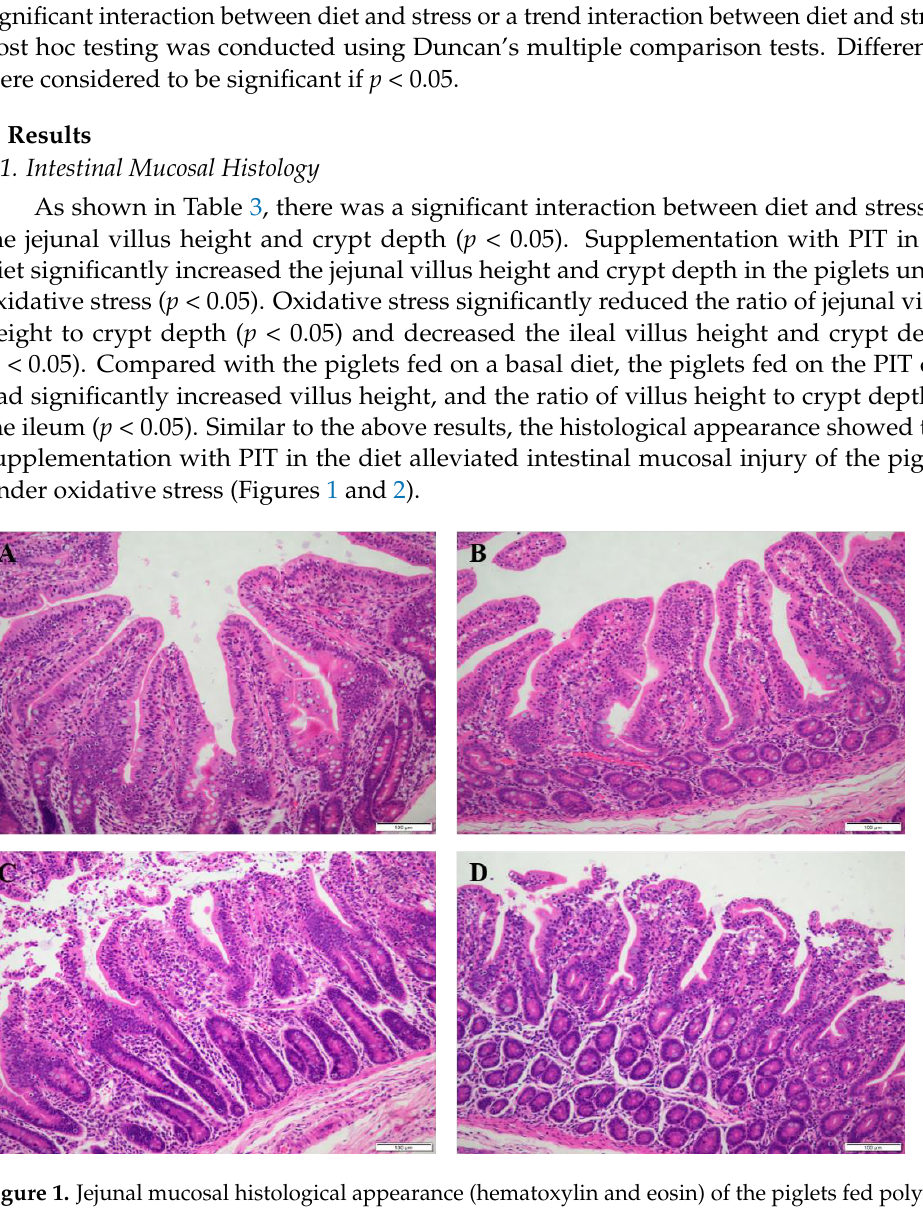
Table 3. The intestinal mucosal histology of the piglets fed polyphenols sourced from Ilex latifolia Thunb. (PIT) diets under oxidative stress.